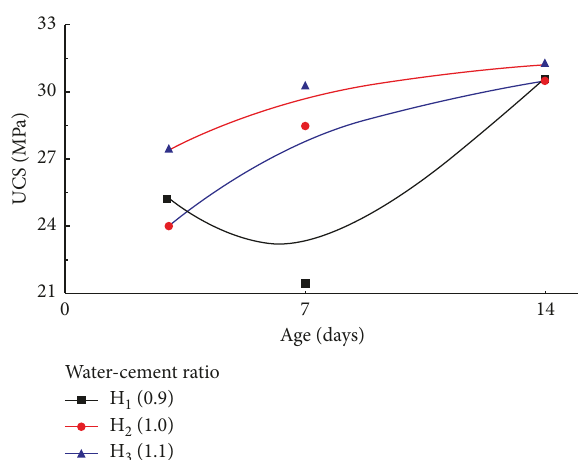
Figure 2: Compressive strength of different water-cement ratios.